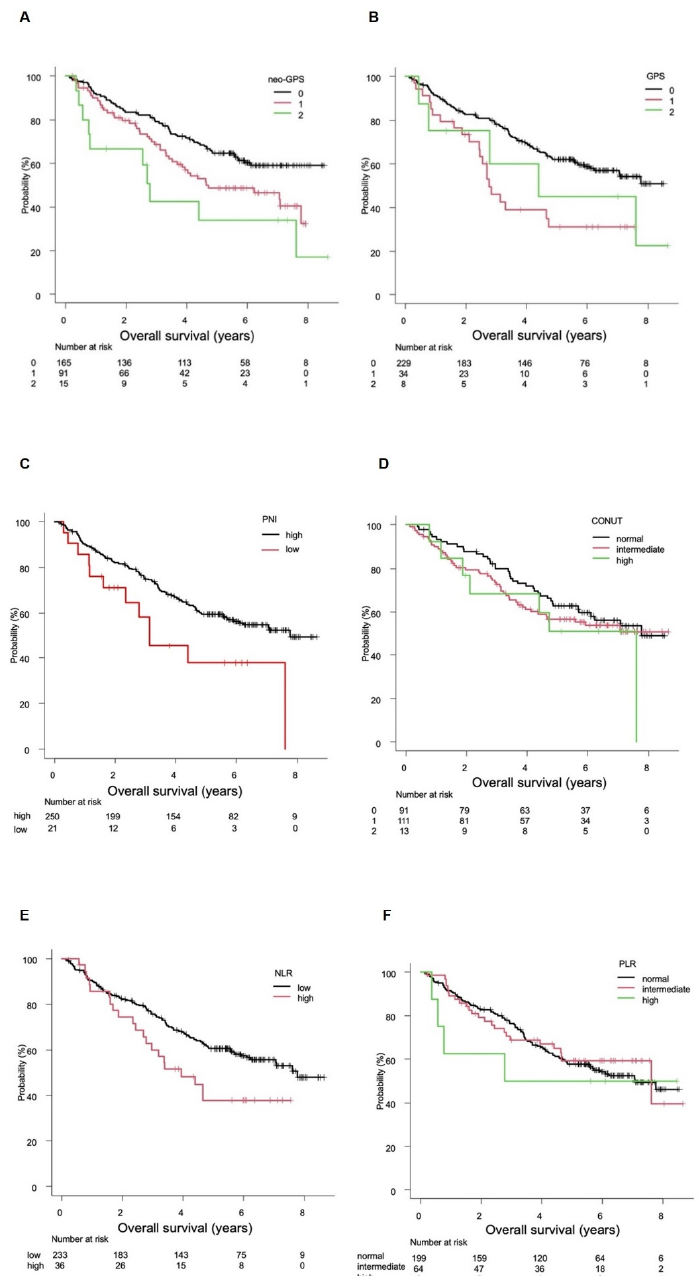
Figure 1. Overall survival (OS) according to assessment tool. ( A ) The median survival times (MSTs) were not evaluable (NE) (95% confidence interval [CI] not applicable [NA]–NA]), 4.7 (95%CI 3.5–7.8) years, and 2.8 (95%CI 0.6–7.6) years in patients with neo-Glasgow prognostic scores of 0, 1, and 2, respectively ( p = 0.002). ( B ) The MSTs were NE (95%CI 6.2 years–NA), 2.8 (95%CI 2.4–4.7) years, and 4.4 (95%CI 0.4–NA) years in patients with GPSs of 0, 1, and 2, respectively ( p = 0.002). ( C ) The MSTs were 7.8 (95%CI 5.9 years–NA) and 3.1 (95%CI 1.6–NA) years in patients with high (>40) and low ( ≤ 40) prognostic nutritional indexes (PNIs), respectively ( p = 0.022). ( D ) The MSTs were 7.8 (95%CI 5.7–NA) years, NE (4.1 years–NA), and 7.6 (95%CI 1.9–NA) years in patients with normal, intermediate, and high controlling nutritional status scores, respectively ( p = 0.554). ( E ) The analysis for neutrophil/lymphocyte ratio (NLR; n = 269) indicated that the MSTs were 7.8 (95%CI 6.1–NA) and 3.9 (95%CI 2.7–NA) years in patients with low (<4.0) and high ( ≥ 4) NLRs, respectively ( p = 0.031). ( F ) The MSTs were 7.1 (95%CI 5.6–NA), 7.6 (95%CI 4.6–NA), and 2.8 (95%CI 0.4–NA) years in patients with normal, intermediate, and high platelet/lymphocyte ratios, respectively ( p =